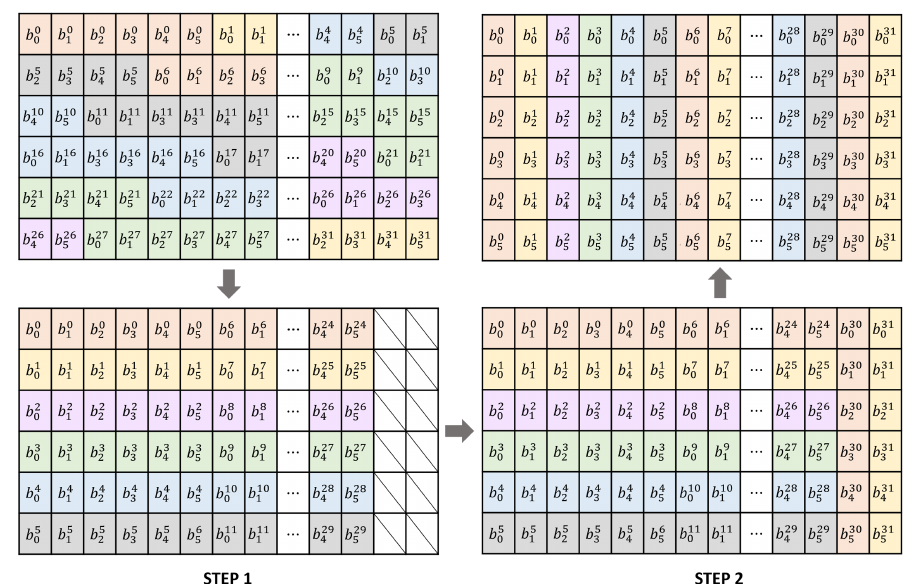
, where i is the index of the block, and j is the j